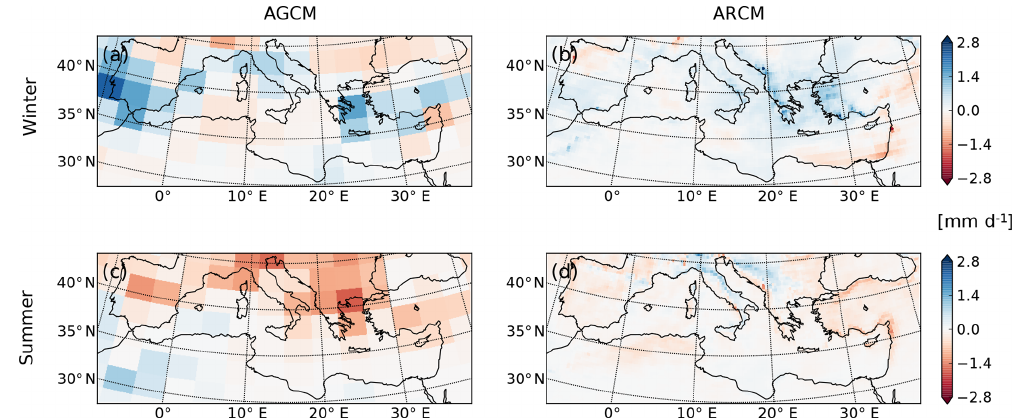
Figure 10. Same as in Fig. 8 but for precipitation rate (mmd − 1